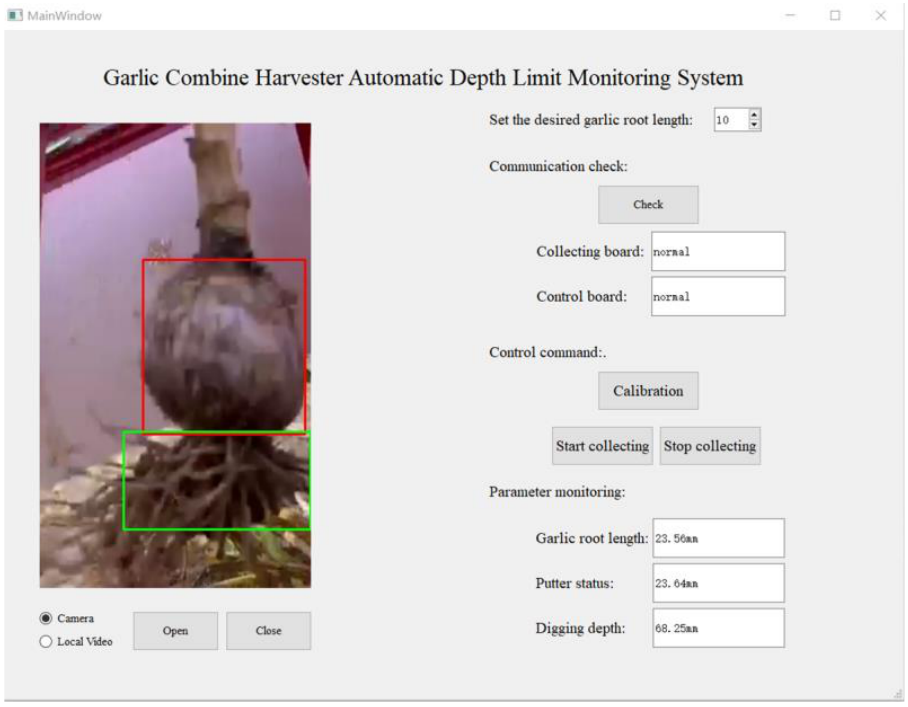
Figure 19. Upper computer monitoring interface.